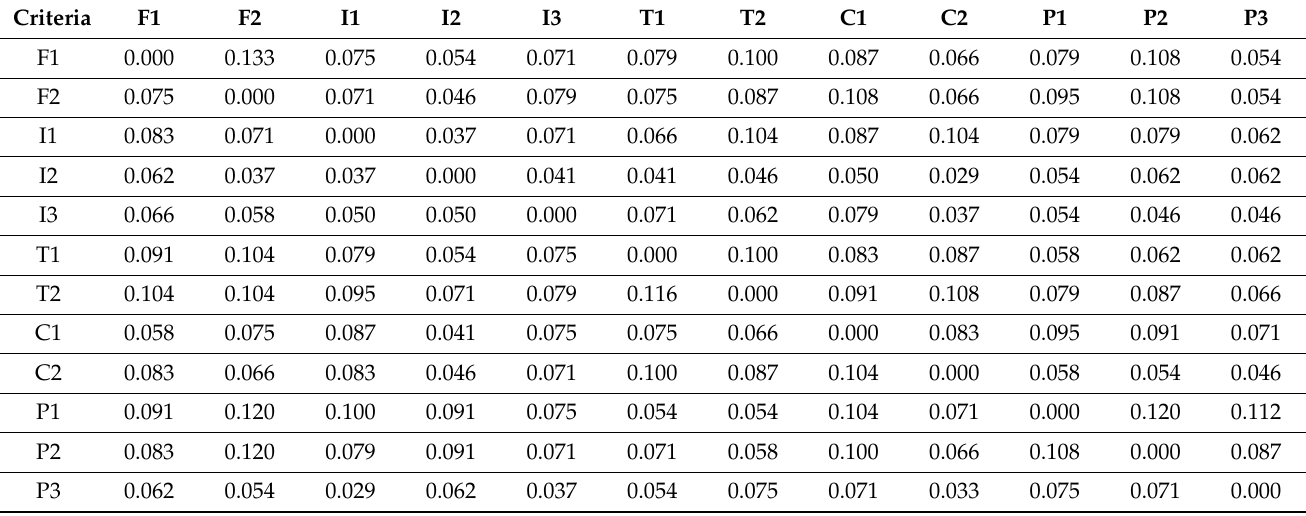
Table A4. Normalized direct relation